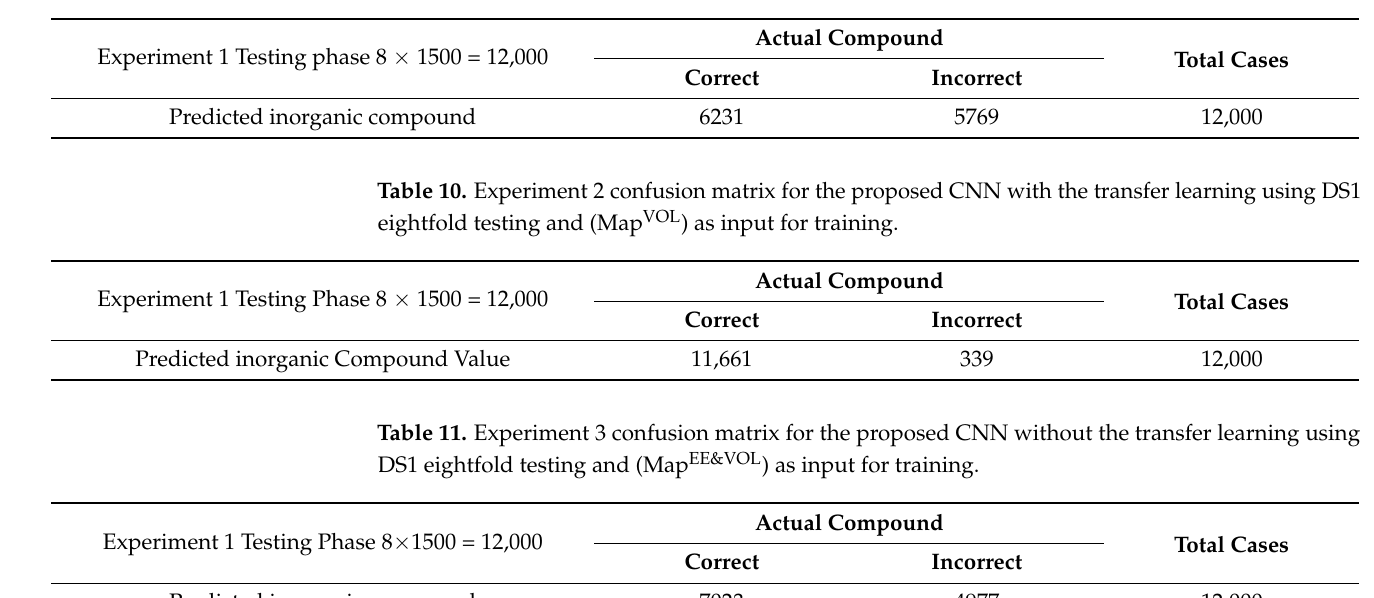
Table 9. Experiment 2 confusion matrix for the proposed CNN without the transfer learning using DS1 eightfold testing and (Map VOL ) as input for training.